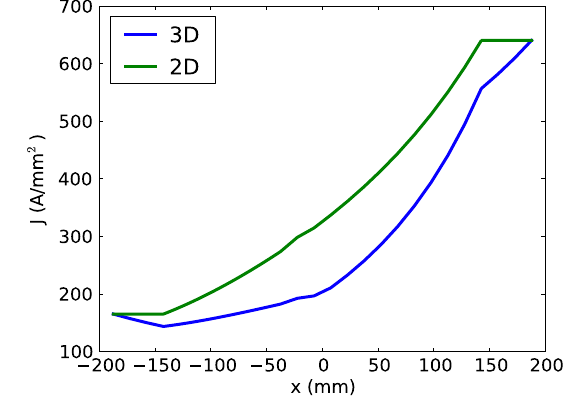
FIG. 43. Current density in the bedstead coils as a function of the horizontal position. Shown are the theoretically required current density for a 2D case and the final current density in the model, which takes into account the different lengths of the bedstead magnets and nonlinearities of the iron yoke.